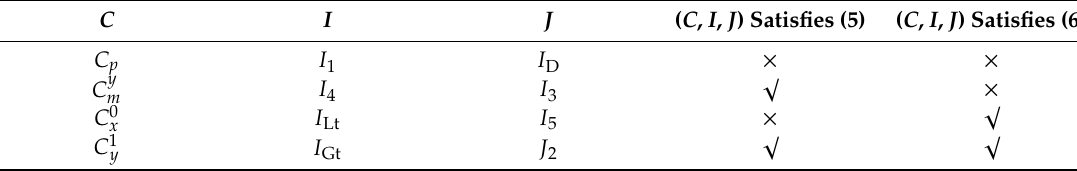
Table 2. The relationships between (5) and